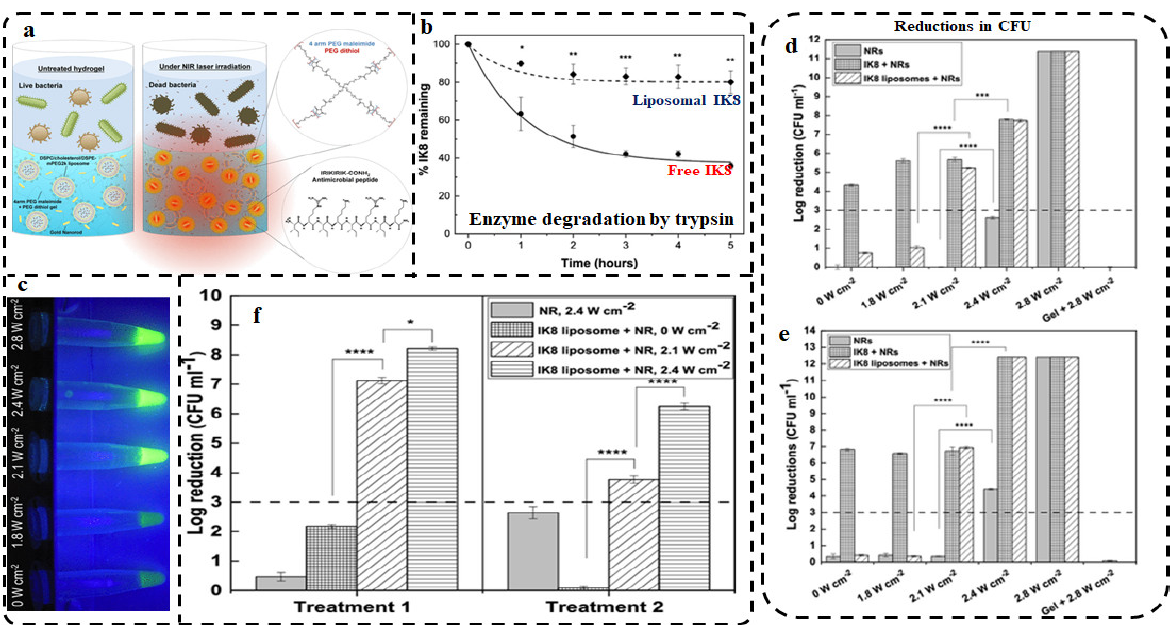
Figure 8. Controlled release and thermal enhancement of IK8-conjugated AuNR-loaded hydrogel. Mechanism of IK8 release triggered by laser irradiation of AuNRs ( a ); proteolytic effect of trypsin on IK8 and liposome IK8 over the course of 5 h, * p ≤ 0.05, ** p ≤ 0.01, *** p ≤ 0.001 ( b ); irradiation of the AuNR-loaded hydrogels at 850 nm with ranging intensities from 0 to 2.8 W/cm 2 ( c ); Antibacterial effect of laser-irradiated hydrogels against S. aureus , *** p ≤ 0.001, **** p ≤ 0.0001 ( d ); and P. aeruginosa , **** p ≤ 0.0001 ( e ); and activity of different formulations on S. aureus over two treatment cycles after 5 (treatment 1) and 10 (treatment 2) min laser irradiation, * p ≤ 0.05, **** p ≤ 0.0001 ( f ). Reprinted with permission: Copyright © 2020 American Chemical Society: https://pubs.acs.org/doi/10.1021/acsami.9b22587, access on 20 May 2021, fur- ther permissions related to the material excerpted should be directed to the ACS [191] .